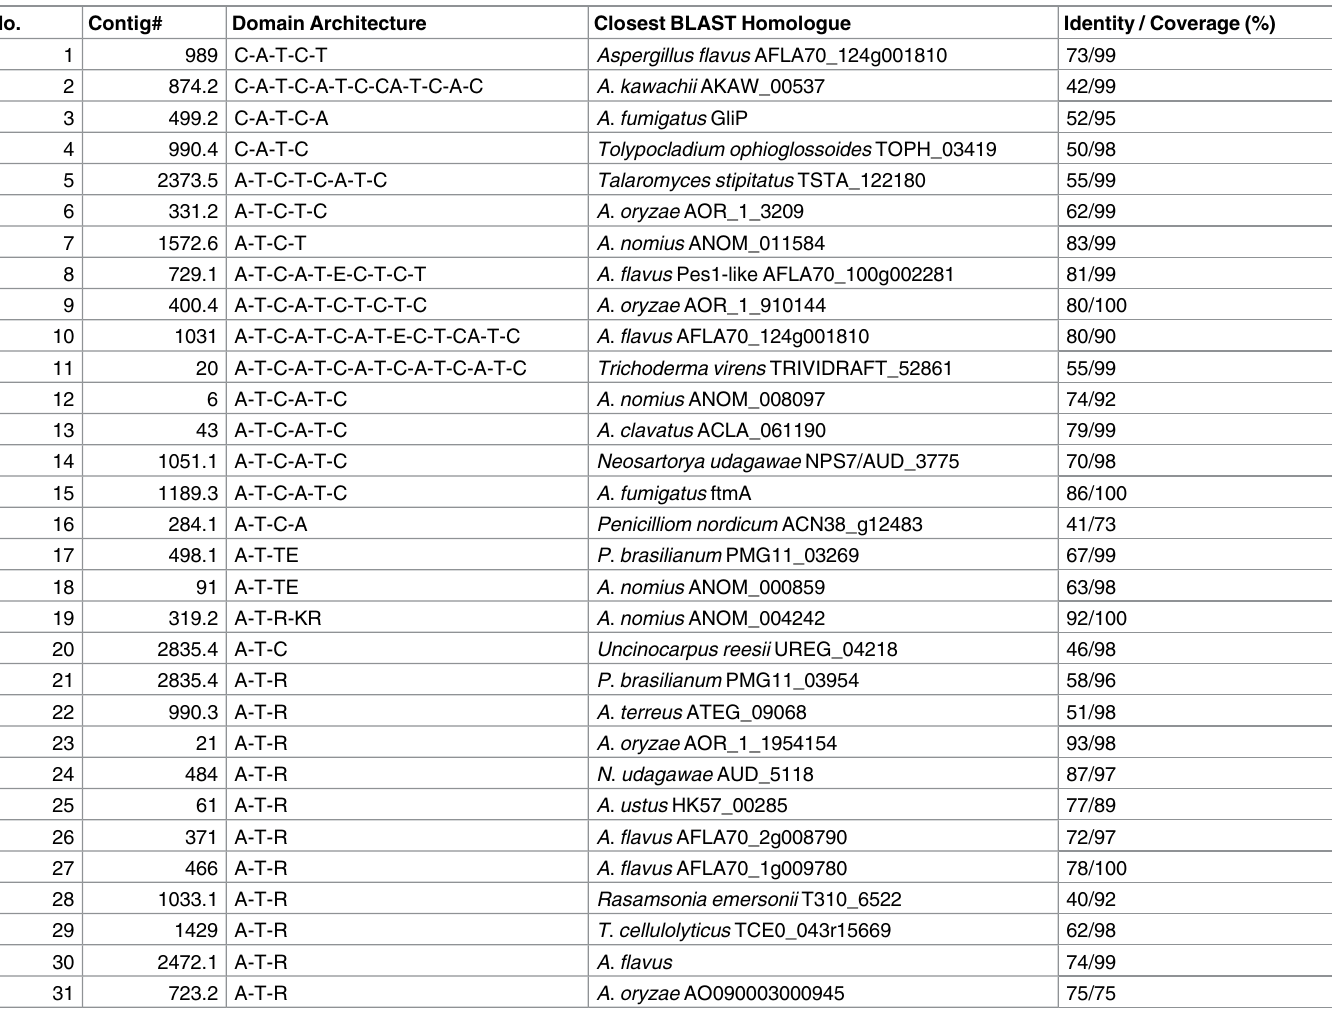
Table 5. Nonribosomal peptide synthases (NRPSs) and NRPS-like enzymesencoded in the A . hancockii genome (excluding PKS-NRPS hybrids). No.